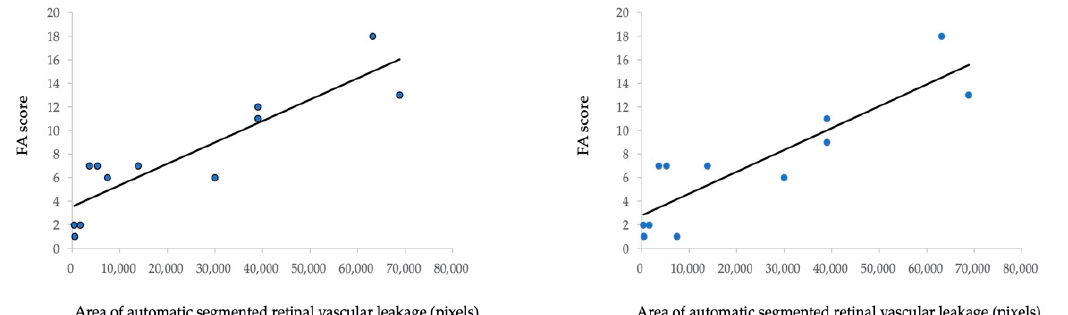
Figure 4. Correlation between FA score and pixels of the automated detected leakage area in 12 UWF FA images from six patients (before and after treatment). ( a ) Correlation between the FA score (a total of 40 points summarized from nine parameters) and pixels of the automated detected leakage area. ( b ) Correlation between the FA score (a total of 24 points summarized from four parame- ters: optic disc hyper fluorescence, macular edema, retinal vascular staining/leakage, and capillary leakage) and pixels of the automated detected leakage area.